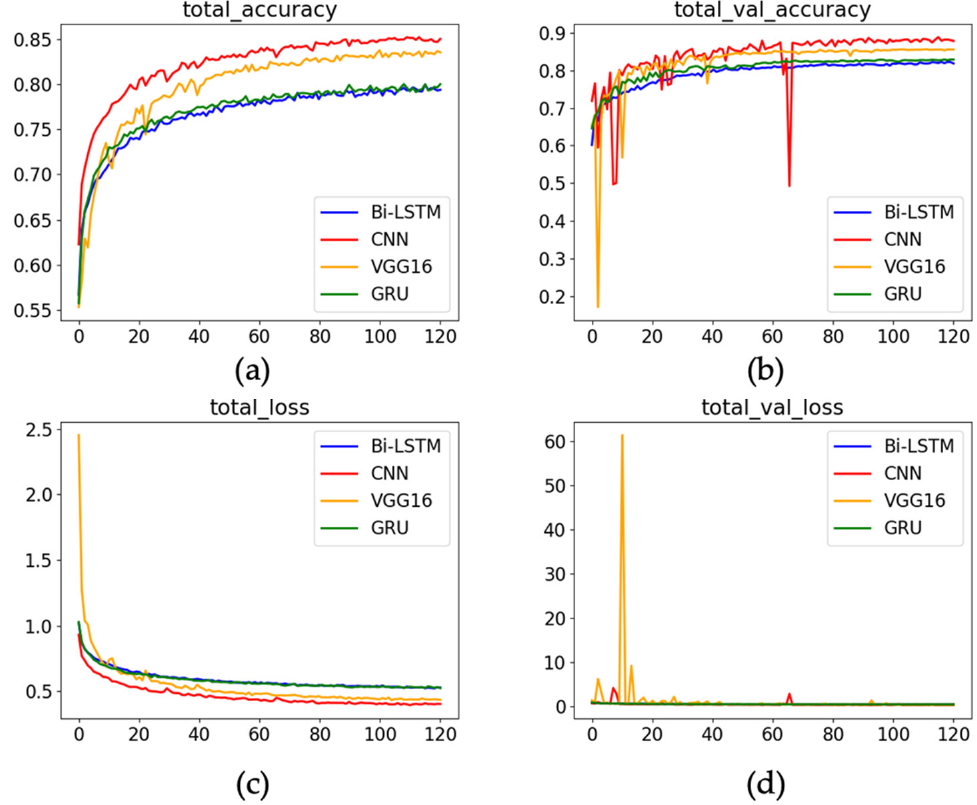
Figure 7. The curve of the training results for the chest X-ray film per model in ( a ) accuracy of the training data, ( b ) accuracy of the validation data, ( c ) total loss of training data, and ( d ) total loss of validation data.